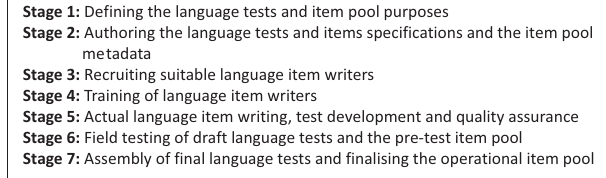
Stage 1: Defining the language tests and item pool purposes Stage 2: Authoring the language tests and items specifications and the item pool metadata Stage 3: Recruiting suitable language item